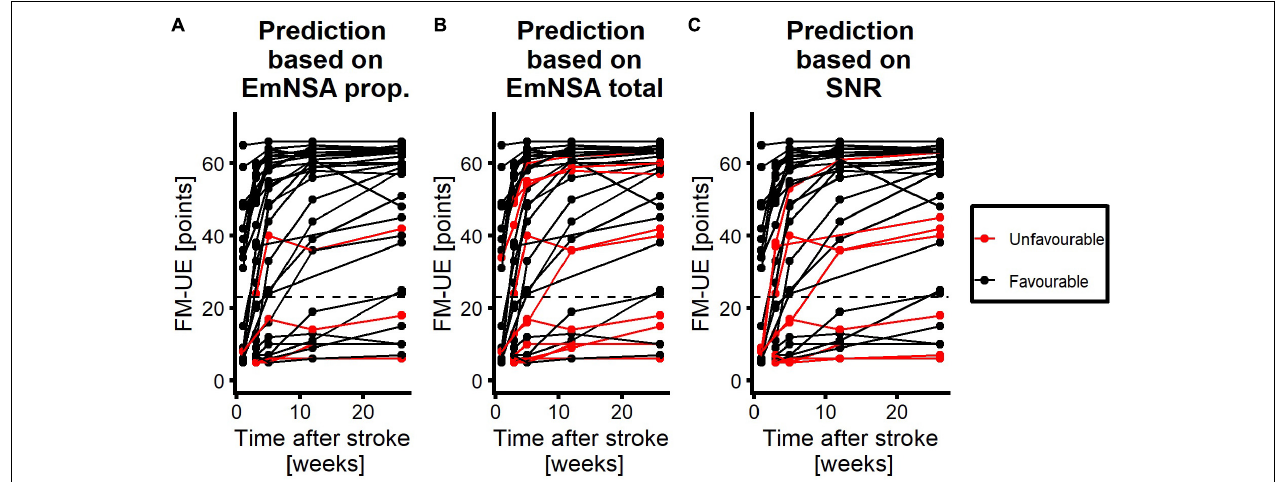
FIGURE 6 | Performance of each predictor to predict motor function at 26 weeks after stroke. Red curves represent patients with unfavorable prognosis, i.e., they are expected to have an FM-UE score smaller than or equal to 22 at 26 weeks after stroke. Black curves represent patients with favorable prognosis for motor function at 26 weeks, i.e., they are expected to have an FM-UE score larger than 22 at 26 weeks after stroke. (A) Performance of the proprioception score of the EmNSA-UE. (B) Performance of the total score of the EmNSA-UE. (C) Performance of SNR. Dashed line represents FM-UE = 23 points.